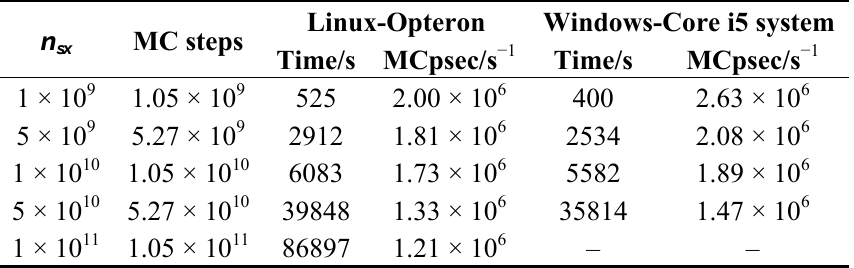
Table 12. Performance analysis; Reaction time = 1 h; [CDB] [MA] , = 11.04 0